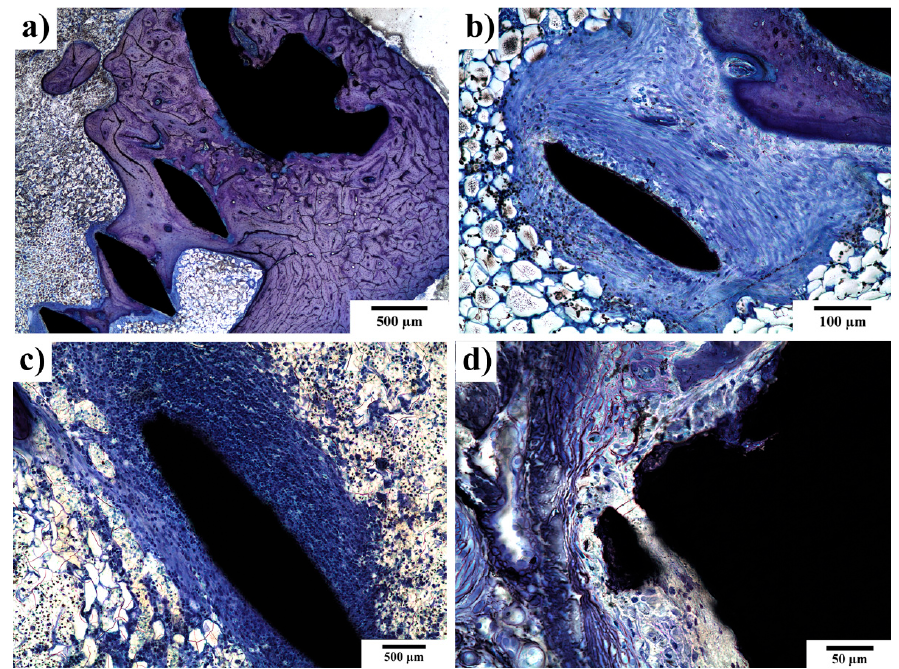
Figure 7. Peri-implant fibrosis around experimental screw 120 days after implantation. ( a ) The whole surface of the experimental screw was covered with fibrosis; ( b ) under high magnification, remnants of fibroproductive inflammation, represented by scattered lymphocytes and macrophages in the fibrous tissue, can be traced; ( c ) peri-implant fibrosis with dense lymphocytic infiltrate surrounding the experimental screw; and ( d ) macrophages in close vicinity to the implanted screw. At 120 days after implantation. Toluidine blue staining.